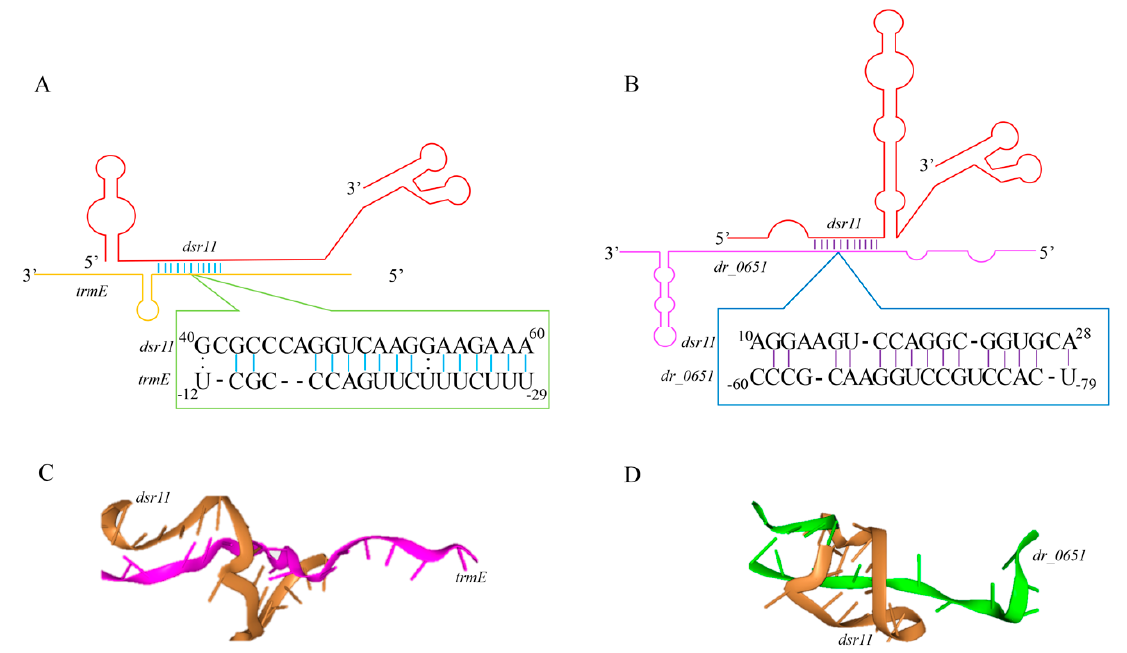
Figure 5. Predicted interaction sites of dsr11 and target genes. ( A , B ) Schematization of the interaction between dsr11 and two target mRNAs based on TargetRNA2. ( C , D ) The tri-dimensional interaction model was predicted by HNADOCK [46].